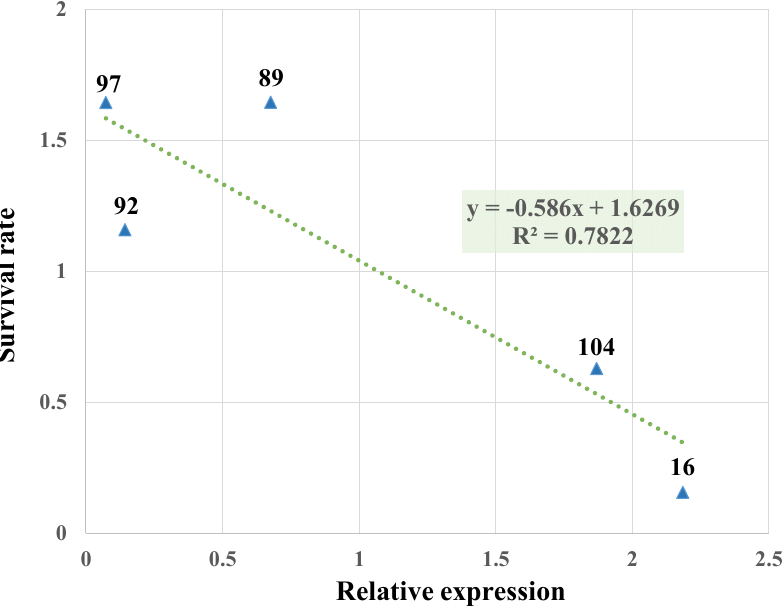
Figure 4. Linear regression equation. The linear regression equation was calculated using the relative expression of the PPA gene as the independent variable and the survival rate of aphids after five days as the dependent variable. Each value is the average of three replicates of the relative expression and aphid survival rate of the